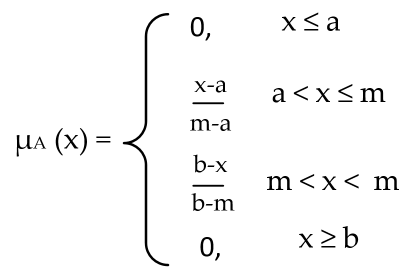
Figure 4. Formulas for triangular membership functions.